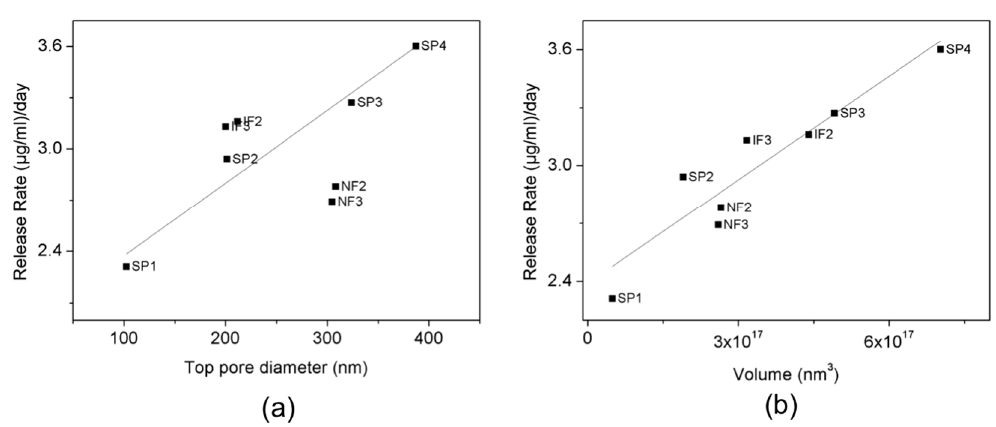
Figure 11. Release rate versus ( a ) top pore diameter, and ( b ) volume, and linear fittings (black straight line).